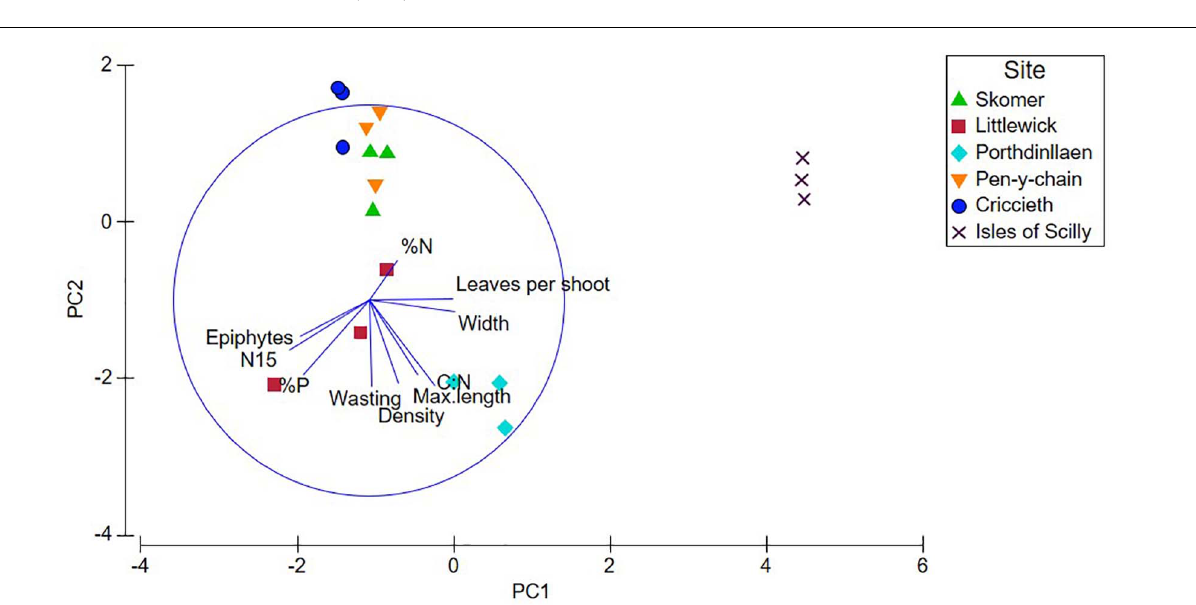
recorded (36.15 ± 22.04). Density was found to be highest in the 2016 survey ( Figure 4 and Supplementary Table A.6 ),